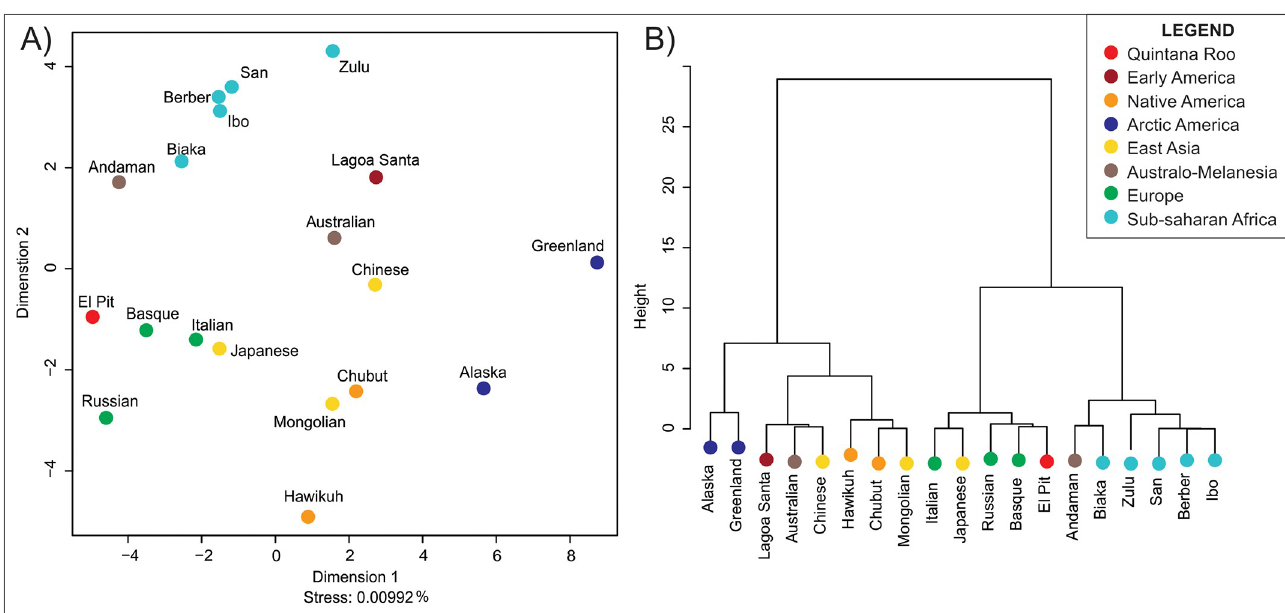
Fig 4. Morphological affinities between El Pit I and reference series according to Mahalanobis distances of the first two Principal components. A) Multidimensional Scaling. B) Ward’s Cluster.